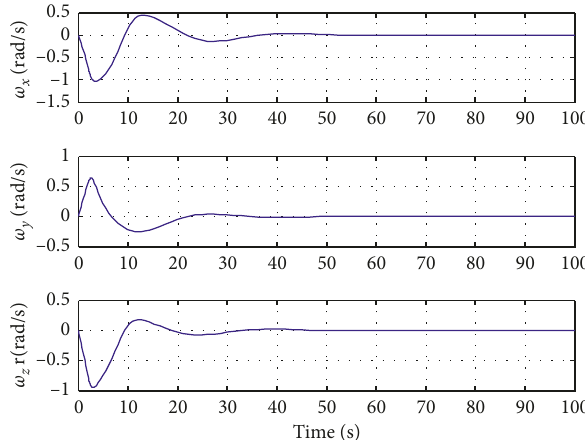
Figure 2: Time response of attitude σ when Φ � 200 ∘ .